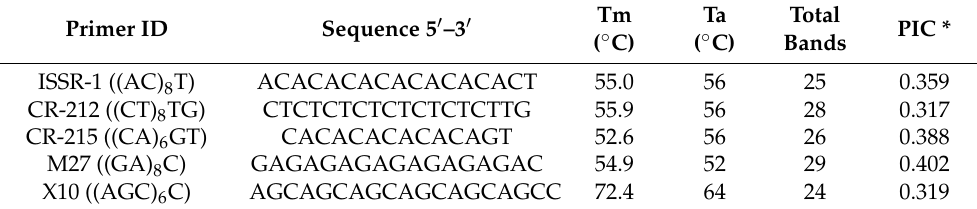
(Table 1). The reproducibility of ISSR-profiles was verified based on comparison of the electrophoretic profiles of randomly selected P. sylvestris samples. Data were generated and compared in three replicates. Gels were then checked to identify ISSR-profiles in one or both replicates (original gel-photo collected at the Supplementary Materials Figures S1–S21). Table 1. The information of ISSR primers used to assess genetic diversity of P. sylvestris . Primer ID Sequence 5 (cid:48) –3